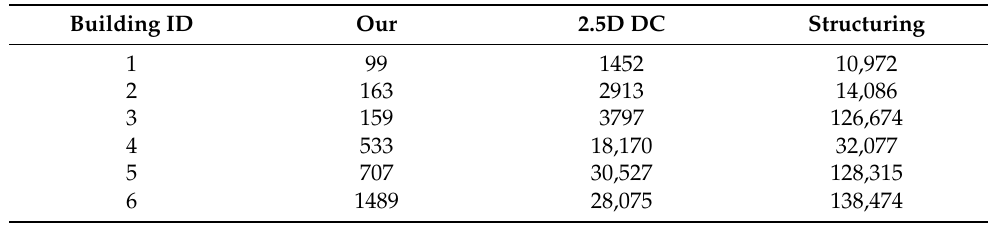
Table 3. Numbers of faces in the reconstructed models by our method, 2.5D DC method [55], and structuring method